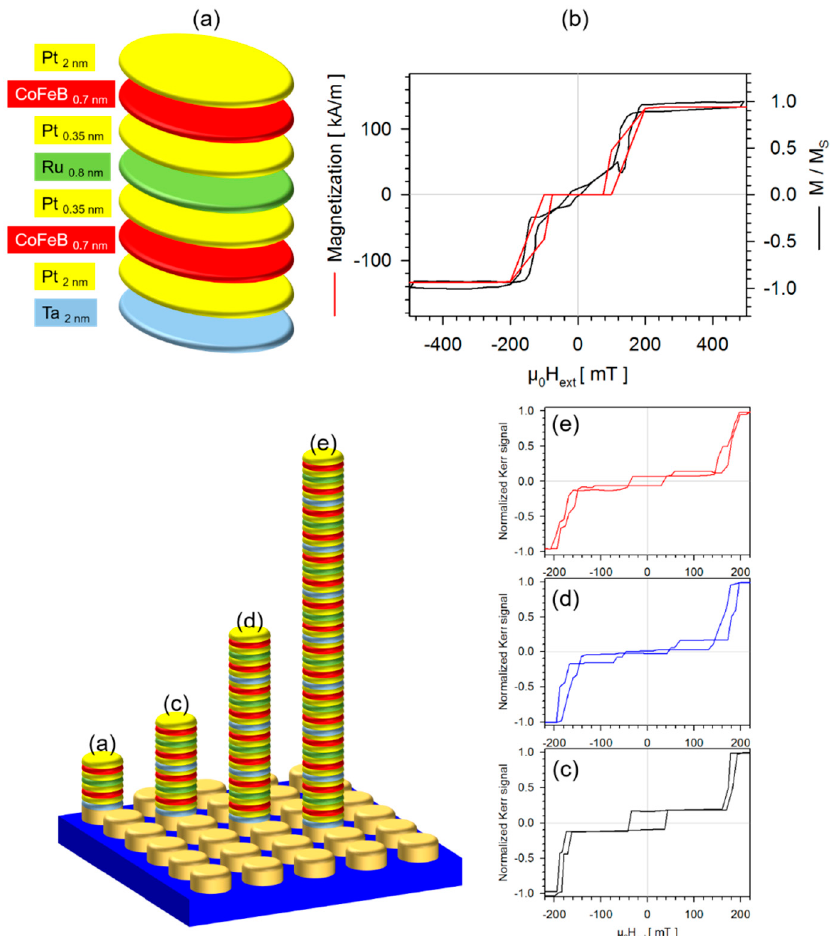
Figure 4. Switching behavior of perpendicularly magnetized synthetic antiferromagnets. ( a ) Basic motif of the layer stack provided with layer thickness. The diameter of the discs are 5 µ m; ( b ) Comparison of the magnetization reversal of particles of the basic motif. In black the normalized magnetization of particles suspended in DI water. The measurements were performed by an alternating gradient magnetometer. In red, a micromagnetic calculation of particles still being arranged in the array. The quasistatic micromagnetic simulation package MicroMagus version 7.1 was employed to do these calculations; ( lower left ) Schematic presentation of a disc array fabricated employing e-beam lithography: positive resist (AR-P 5350) was dripped on a Si / SiO 2 (50 nm) wafer piece and evenly distributed via spin coating (200 rpm for 1 s and 5000 rpm for 30 s). After a backing step at 100 ◦ C for 4 min, e-beam lithography was performed to expose square arrays of pillars, each with 5 µ m in diameter and 10 µ m apart from each other. After exposure and development (developer: AR-300-35, approx. 24 s) only the resist pillars remained. The multilayered stacks were then magnetron sputtered onto these resist pillars: ( a ) the basic motif, ( c ) twice the basic motif, ( d ) 4 times of repetitions of the basic motif and ( e ) 8 times of repetitions of the basic motif. The resist was dissolved with ethanol and particles were suspended in DI water; ( lower right ) Corresponding magnetization reversal determined by polar Moke of all layer stacks ( c – e ) when still being fixed in arrays onto their